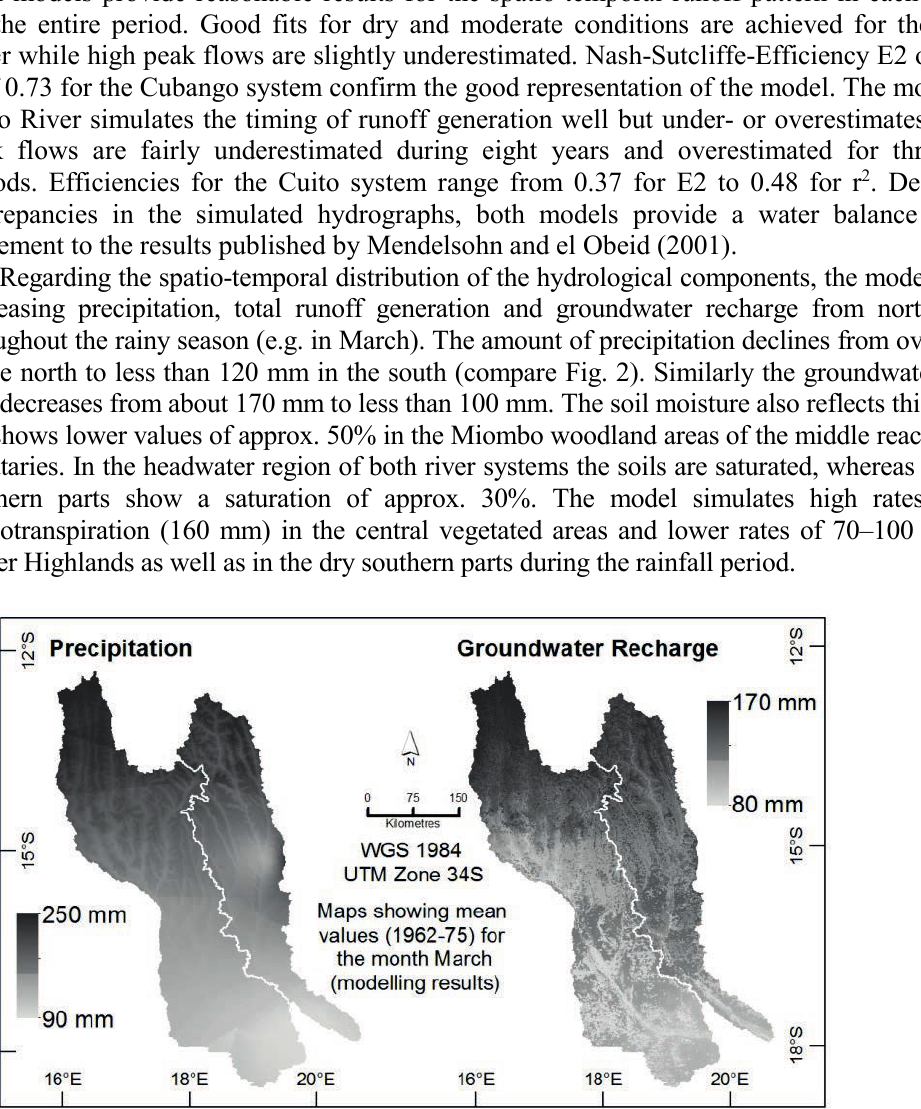
Fig. 2 Modelling results: mean values for precipitation and groundwater recharge for March (mean